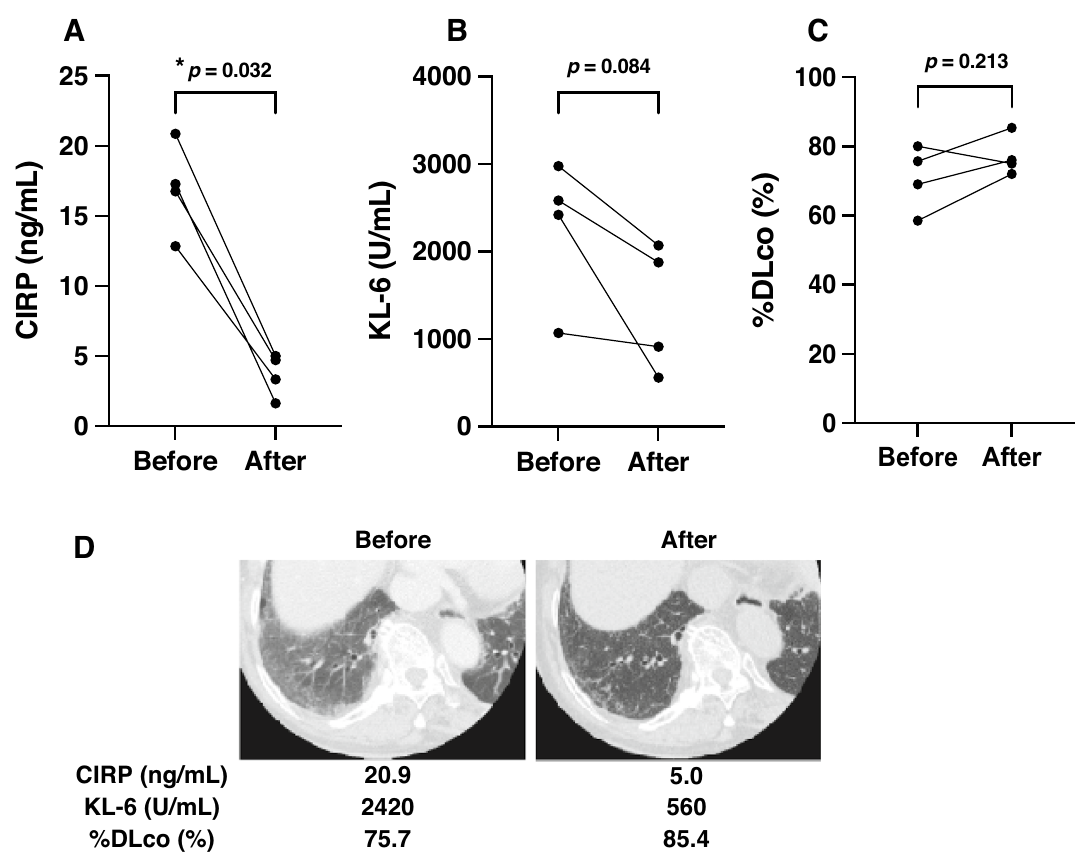
Figure 3. Decrease in serum CIRP levels of SSc patients after treatment for SSc-ILD. ( A ) Decrease in serum levels of cold-inducible RNA-binding protein (CIRP) in four patients with active systemic sclerosis (SSc) before (Before) and after (After) immunosuppressive treatments. ( B ) Decrease in serum levels of Krebs von den Lungen-6 (KL-6) in four patients with active SSc before (Before) and after (After) immunosuppressive treatments. ( C ) Changes in the percent predicted diffusing capacity for carbon monoxide (%DL CO ) in four patients before (Before) and after (After) immunosuppressive treatments for SSc-ILD. ( D ) Images of chest computed tomography from a representative of four patients ( C